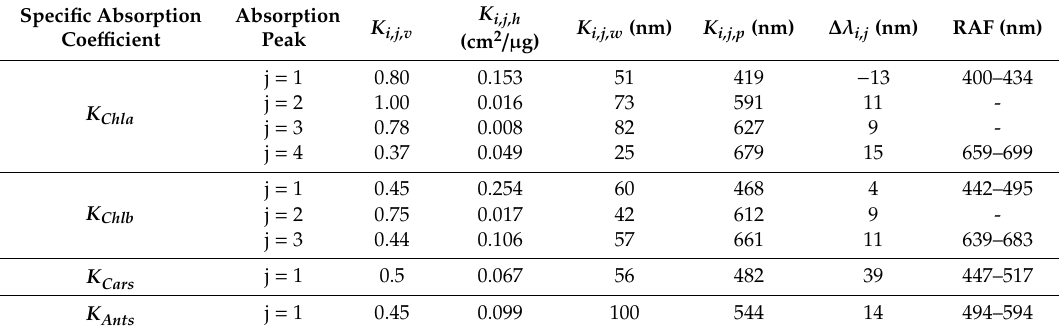
Table 3. Absorption peak characteristics determined from the in vivo pigment absorption coe ffi cients. K i,j,v , K i,j,h and K i,j,w are the Gauss ratio, peak height and full width at half maximum (FWHM) of the j th absorption peak for the i th pigment type in the leaf in vivo, respectively; A i , j , p is the peak position of the j th absorption peak for the i th pigment type; K i , j , ∆ λ is the spectral displacement of the j th absorption peak for the i th pigment type comparing with those in organic solution, and RAF is the range of absorption feature for each absorption peak of pigment absorption coe ffi cients in the leaf in vivo. Specific Absorption Coe ffi